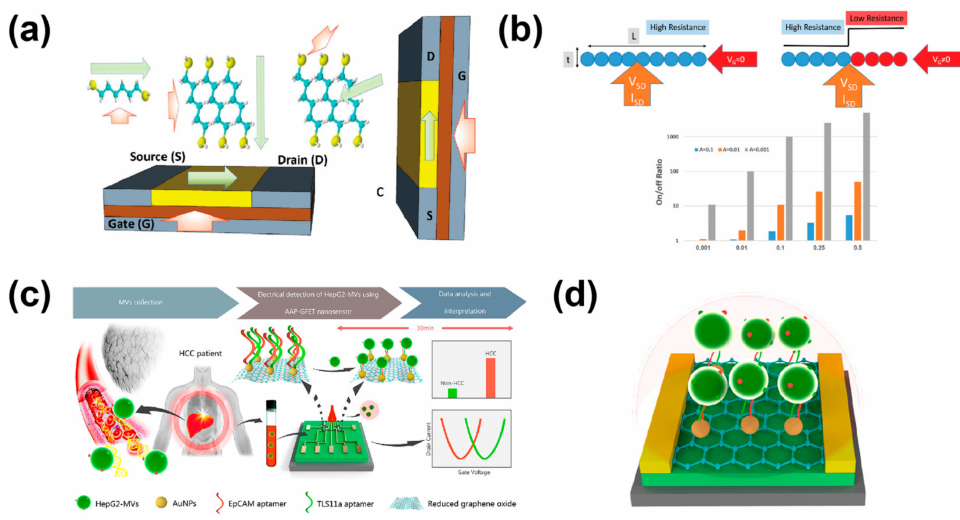
Figure 10. ( a ) Schematic diagram of current and voltage configuration of molecular transistor sensor. ( b ) When the electric field is applied on the molecular transistor sensor, the resistance value changes correspondingly after the voltage changes, thus affecting the transistor performance. ( c ) Nano sensors were used to detect stepped-interpretation of cancer cell derivatives in serum samples. ( d ) Nano sensor specific recognition of liver cancer-related protein markers in serum detection